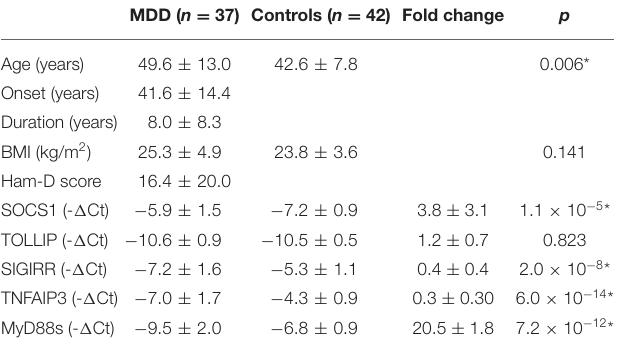
TABLE 1 | Demographic data and mRNA levels of PBMC. TABLE 2 | Demographic data and mRNA levels of PBMC before and after